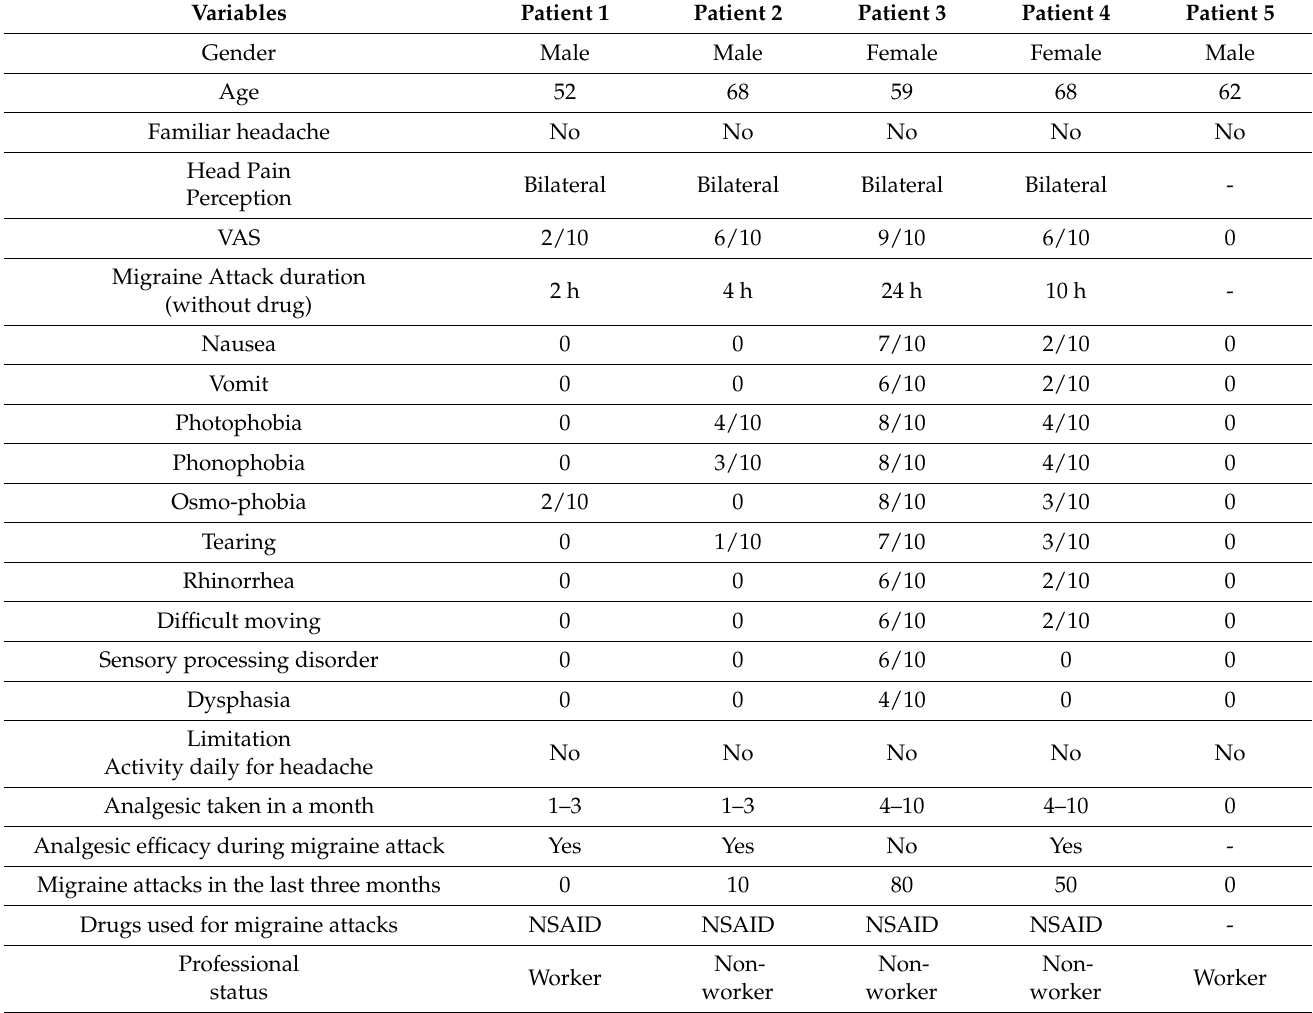
Table 1. Anamnestic data of